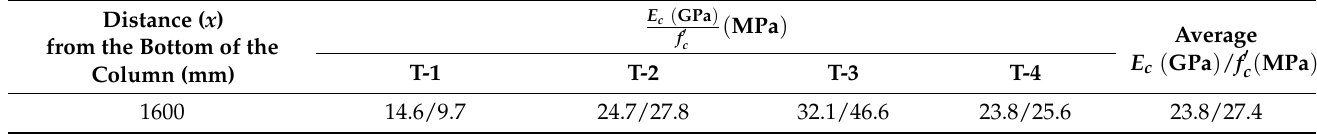
Figure 8. FRF inertance curve by the impact hammer test: ( a ) T-1; ( b ) T-2; ( c ) T-3; ( d ) T-4. Table 3. Estimated elastic modulus and compressive strength of the